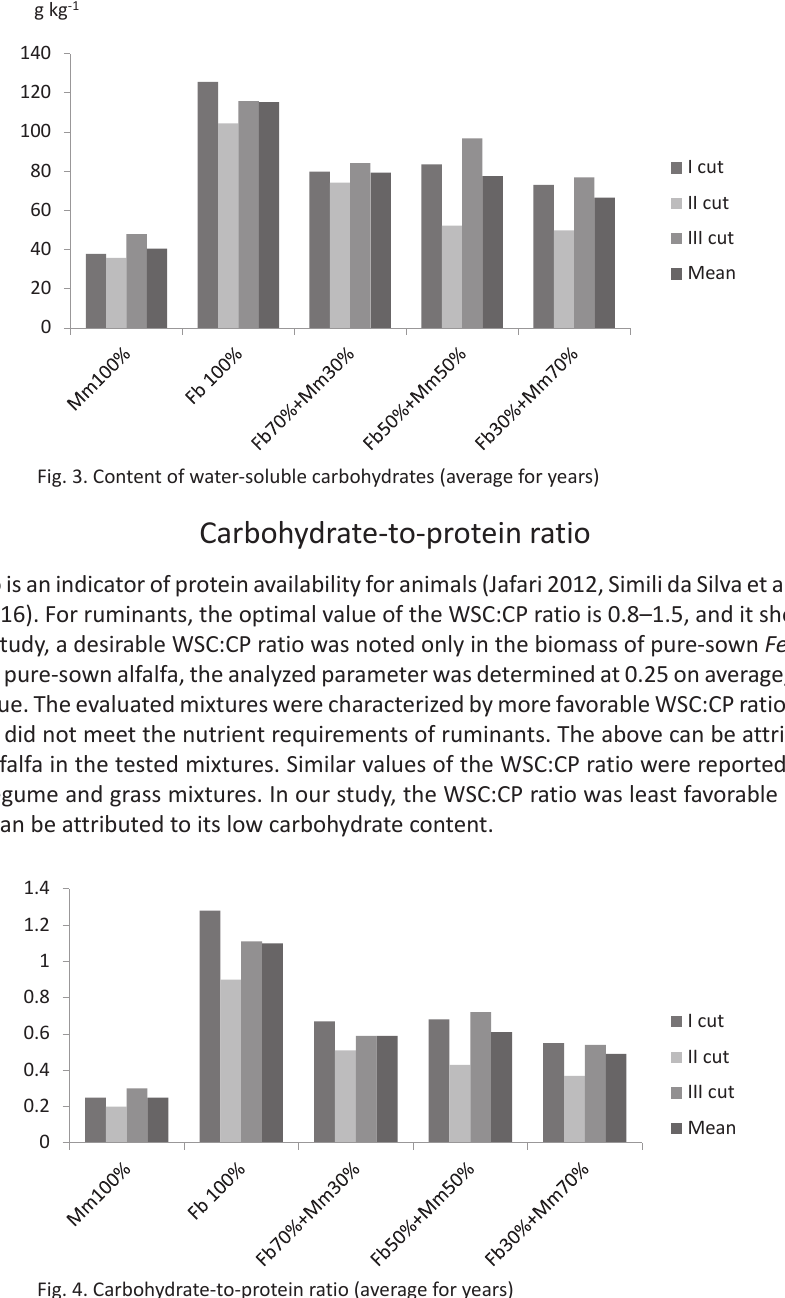
Fig. 4. Carbohydrate-to-protein ratio (average for